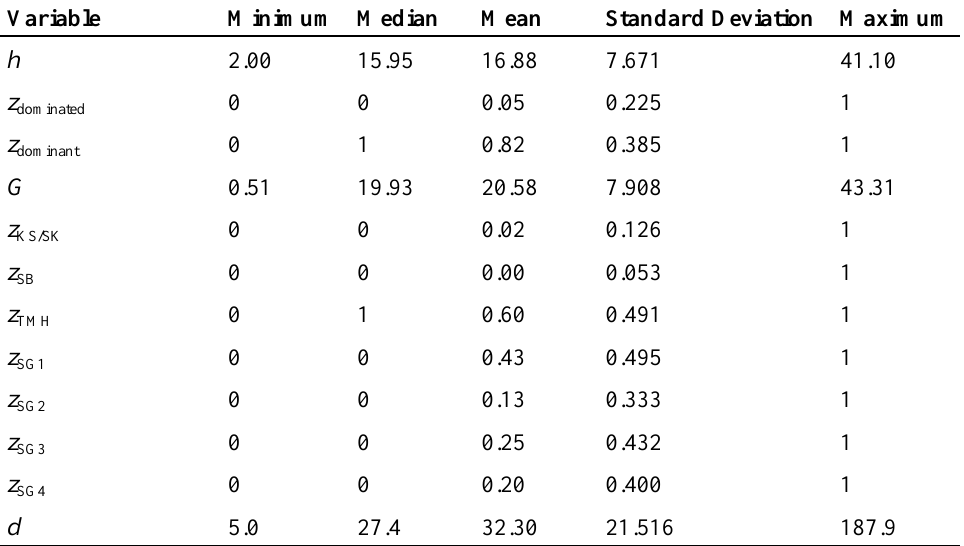
Table A1. Descriptive statistics for the tree-level and plot-level characteristics of the height modeling data: h is the total tree height (m); z and z are dummy dominated dominant variables for the dominated and dominant tree, respectively; G is the stand basal area at the plot-level (m 2 ∙ha −1 ); z , z and z are plot-level dummy variables for the forest types KS/SK SB TMH of Khair Sissoo Forest, Shrub, and Terai Mixed Hardwood Forest, respectively; z – z SG1 SG4 are tree-level dummy variables for species groups 1–4, respectively; and d is the tree diameter at breast height